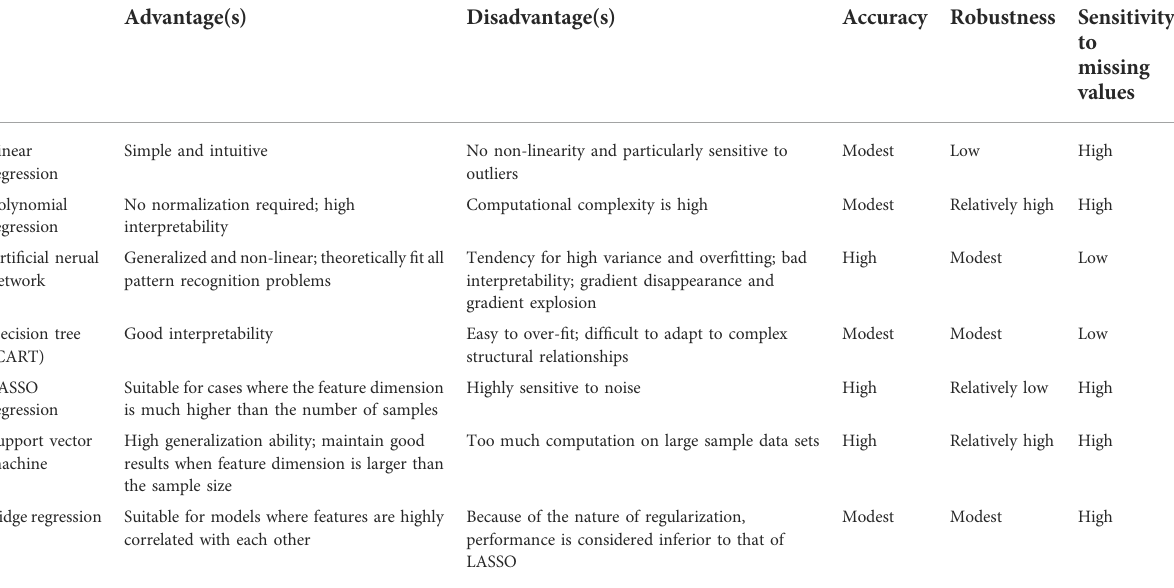
TABLE 1 Comparisons of 7 main machine learning algorithms used in regression tasks.